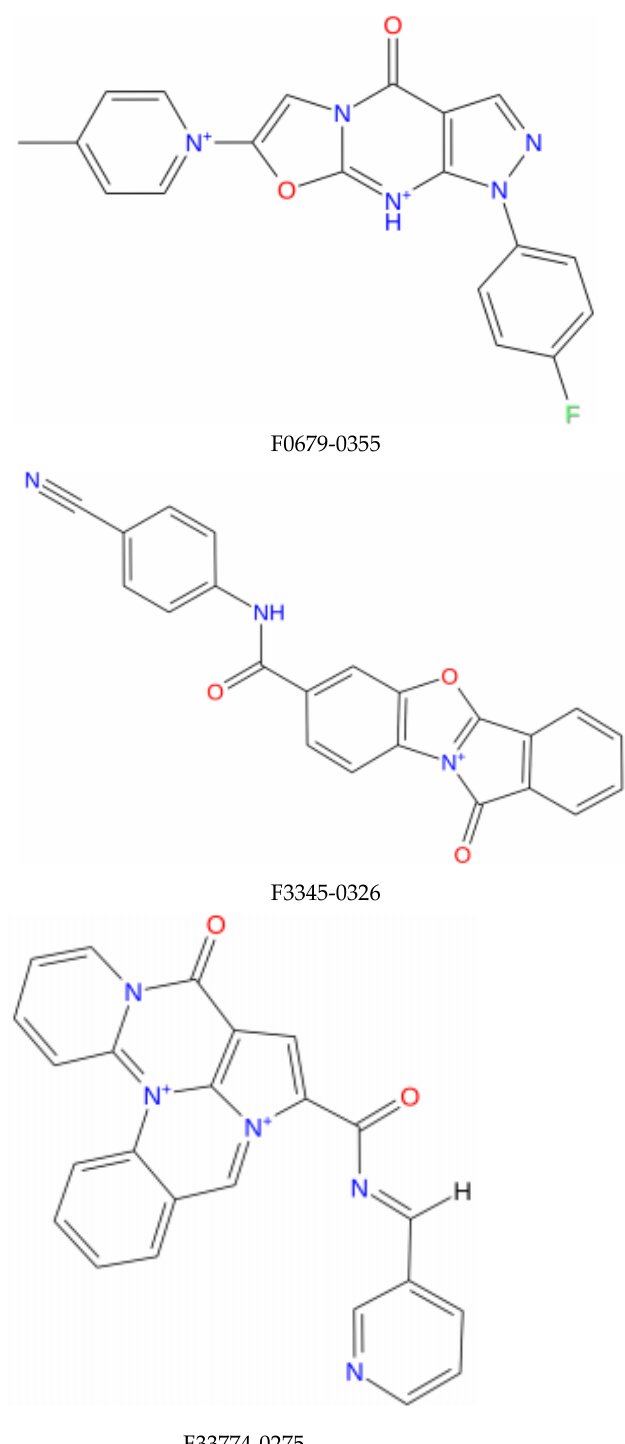
Figure 1 . Structure of the top identified lead compounds Figure 1. Structure of the top identified lead